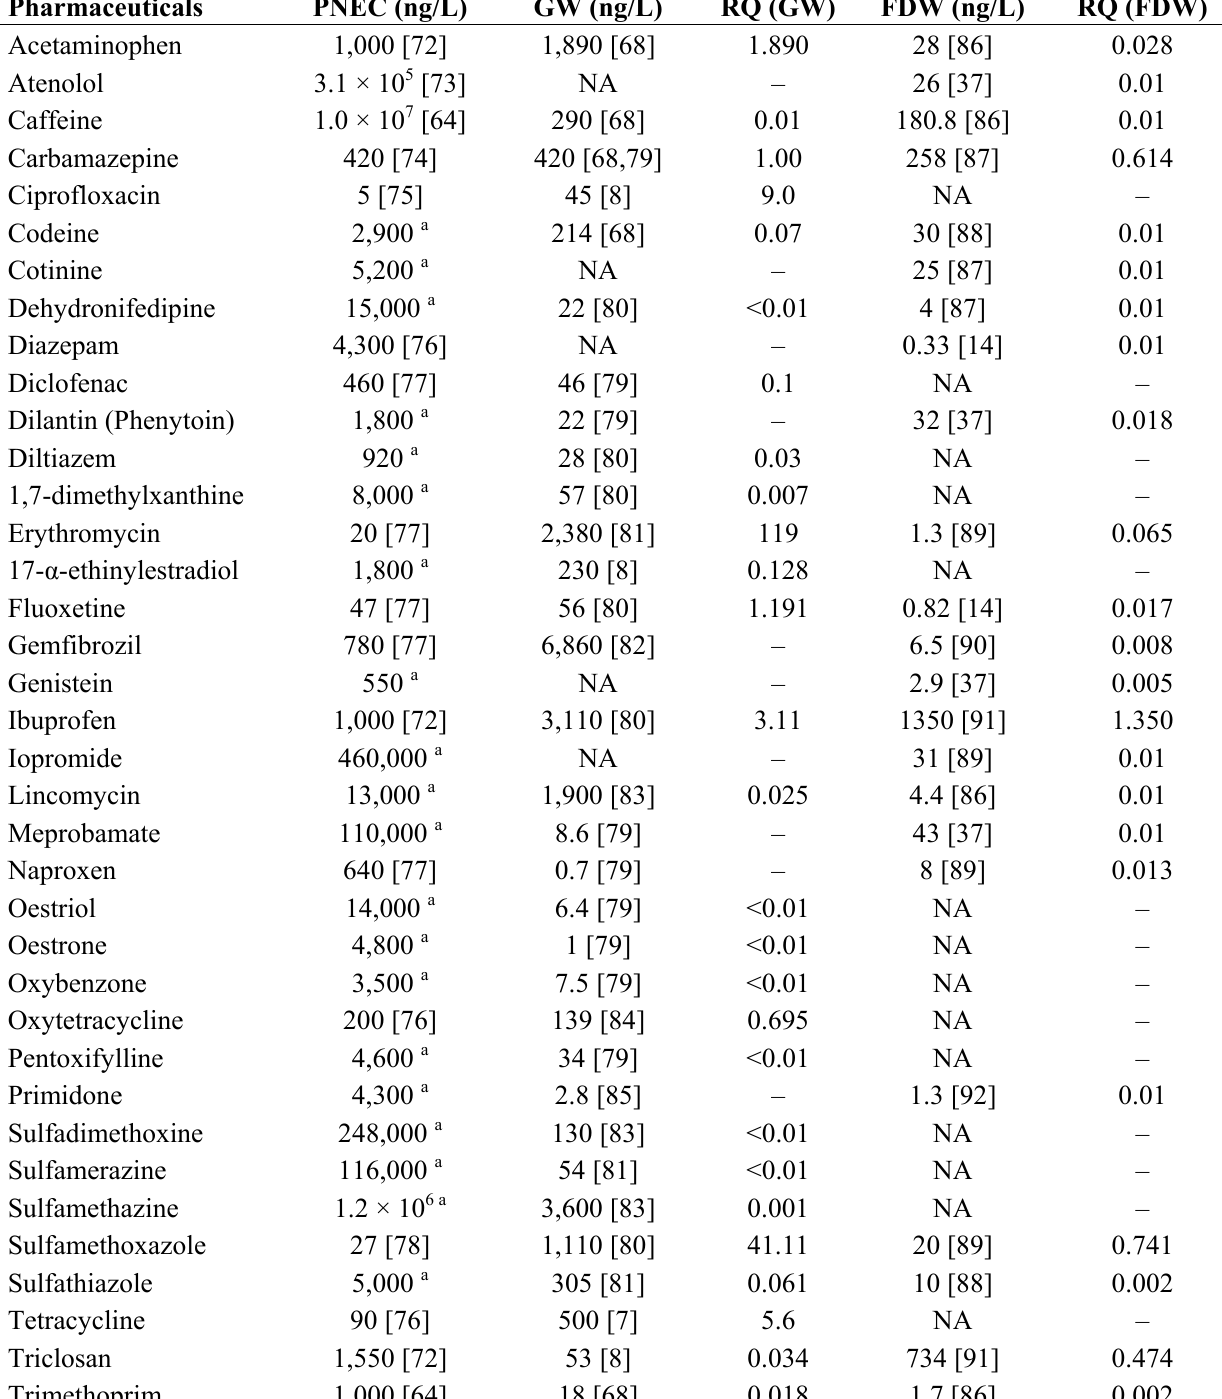
Table 1. Maximum concentrations of pharmaceuticals detected in Groundwater (GW) and in Finished Drinking Water (FDW) of the United States. Also shown are the Predicted No-Effect Concentration (PNEC) and the calculated Risk Quotient